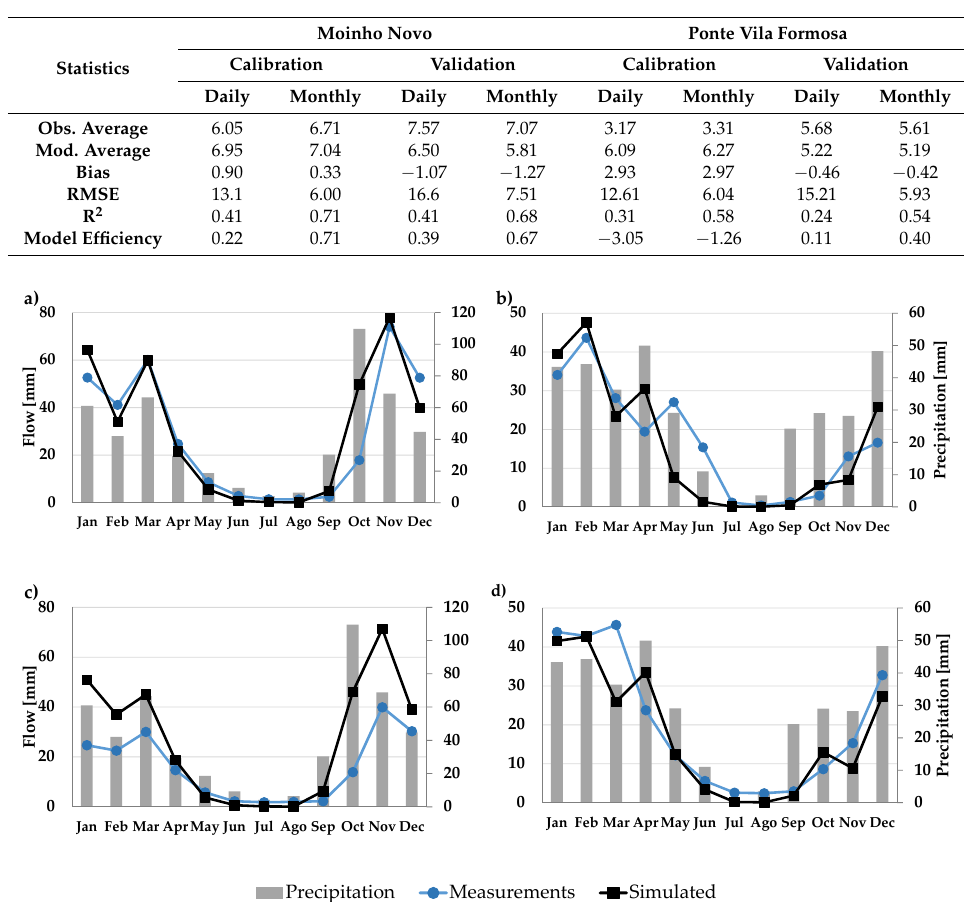
Figure 5. The monthly average flow (mm) in Moinho Novo: ( a ) calibration period; ( b ) validation period; and Ponte Vila Formosa location; ( c ) calibration period; ( d ) validation period.